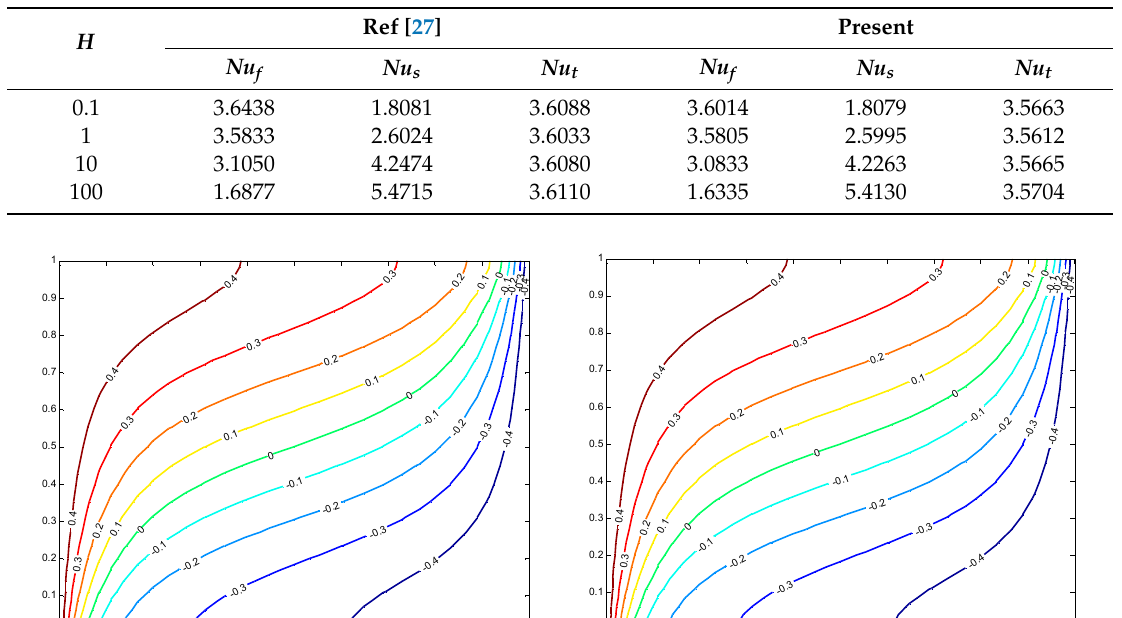
Table 1. Comparison of Nusselt number at Ra = 100 , Kr = 50 , and Rd = 0.5 .